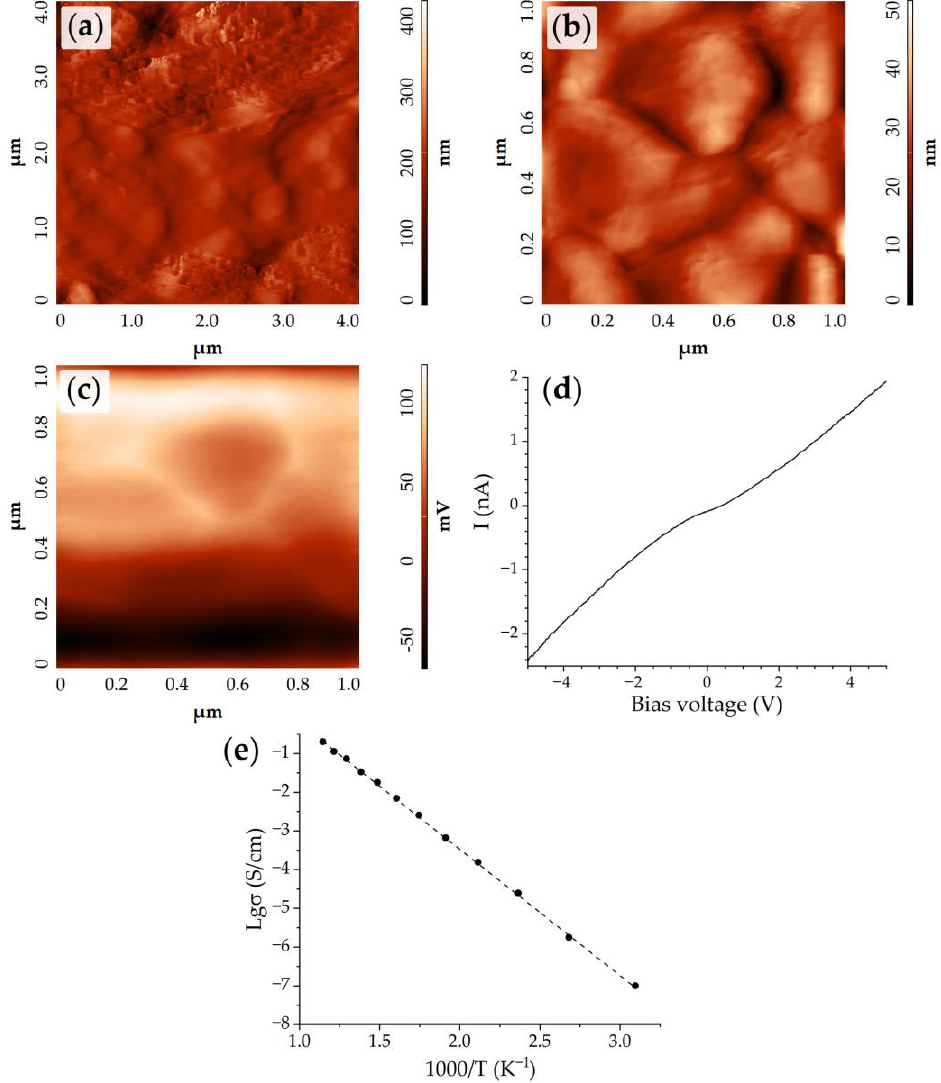
Figure 9. AFM results of the ((CeO 2 ) 0.8 (Sm 2 O 3 ) 0.2 )@NiO composite coating: topography ( a , b ), map of the surface potential distribution (the result of KPFM; ( c )), typical volt – ampere curve for the characteristic local area on the coating surface ( d ). Temperature dependence of the film specific conductivity ((CeO 2 ) 0.8 (Sm 2 O 3 ) 0.2 )@NiO ( e ).